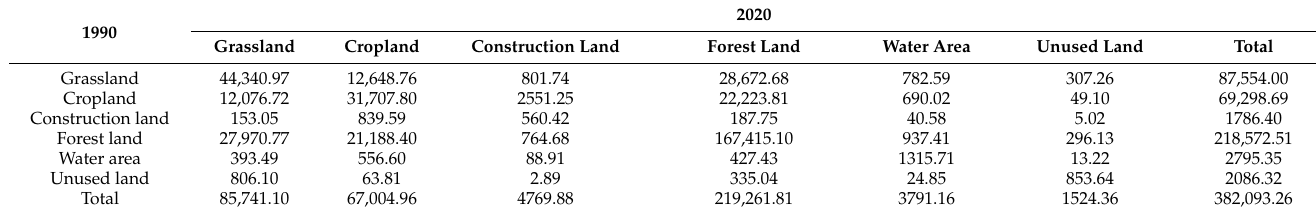
Table 3. Land use transfer matrix of Yunnan Province from 1990 to 2020 (km 2 ).